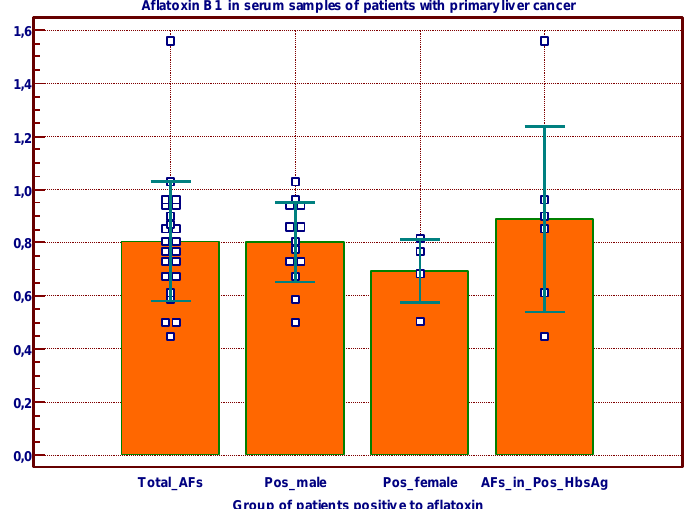
Group of patients positive to